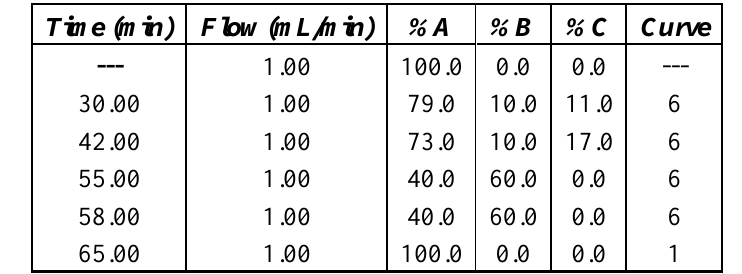
Table 9. Gradient program of polyphenols. Mobile phases: A – 10 mM of phosphate buffered at pH 2.70; B – acetonitrile; C –